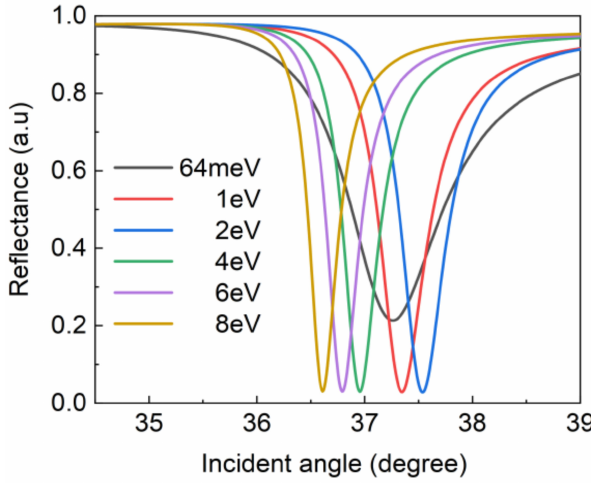
Figure 8. Normalized reflectance of the proposed SPR sensor at different chemical potentials.